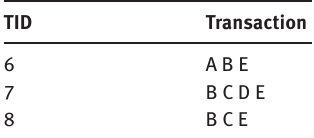
Table 5: Original Frequent Itemsets L Itemset